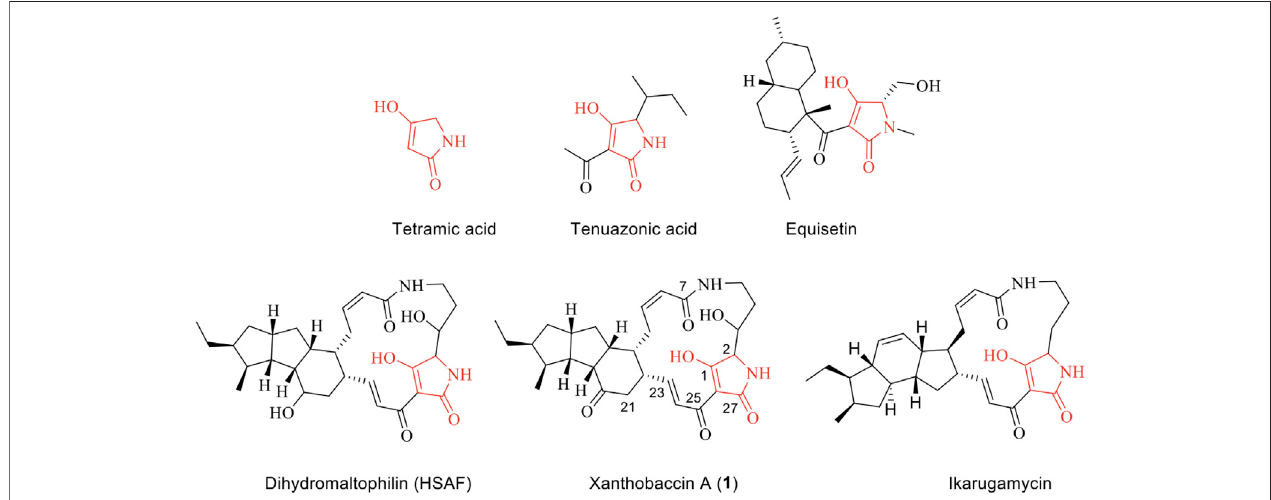
FIGURE 1 | Chemical structure of tetramic acid and selected examples of natural products containing a tetramic acid unit.